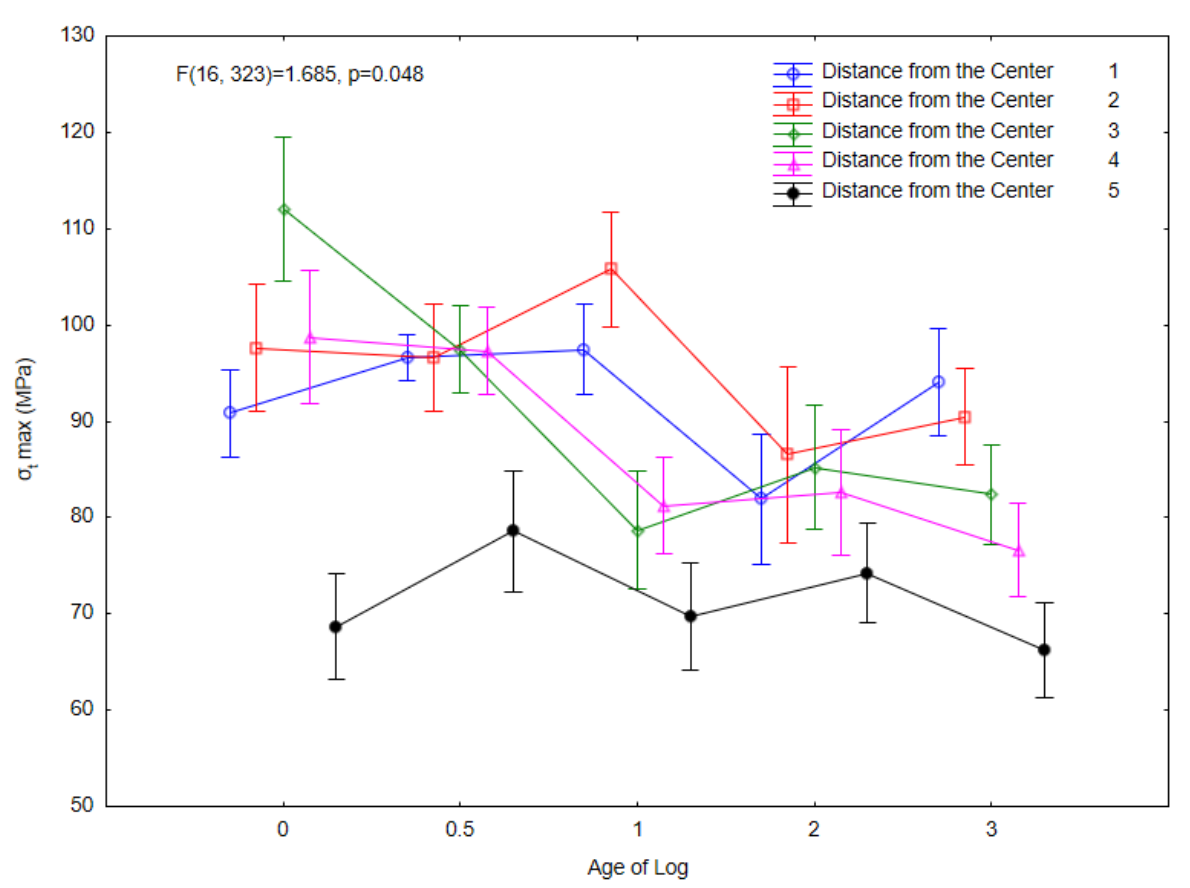
Figure 6. Statistical evaluation of the effect of age of log and distance from center on tensile strength using ANOVA .